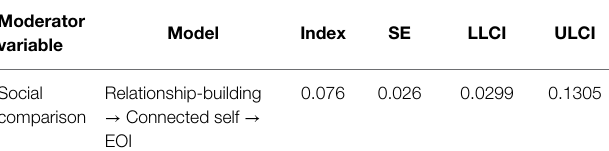
TABLE 5 | Summary of moderated